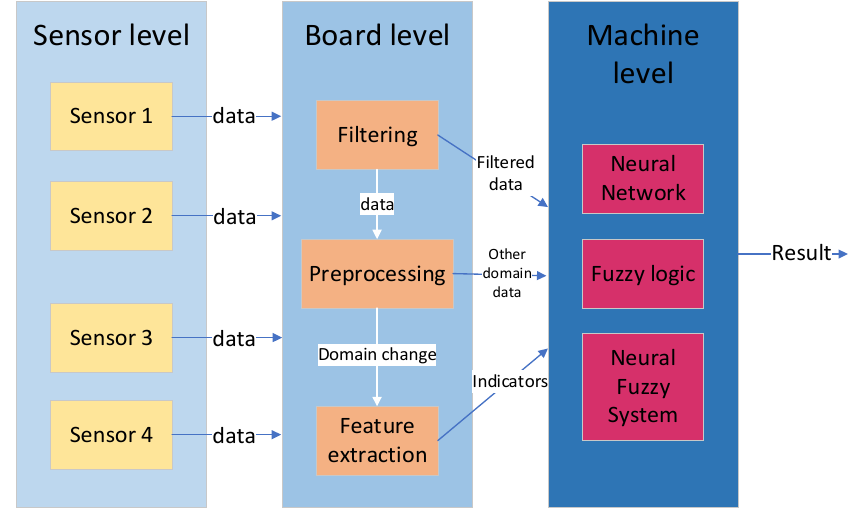
Figure 4. Scheme of the proposed methodology for data